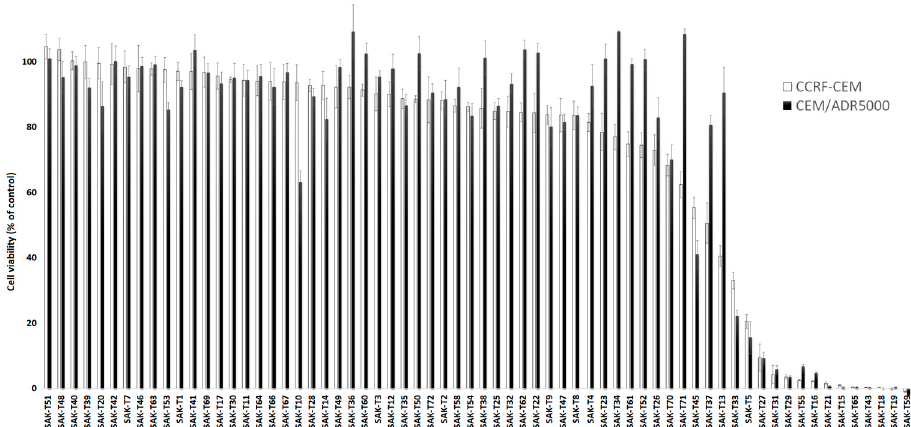
Figure 1. Screening of 69 phytochemicals in drug-sensitive parental CCRF-CEM and multidrug- resistant CEM/ADR5000 cells using the resazurin assay. A fixed concentration of 10 µM of each concentration was used. Shown here are the mean values ± SD of three independent experiments.